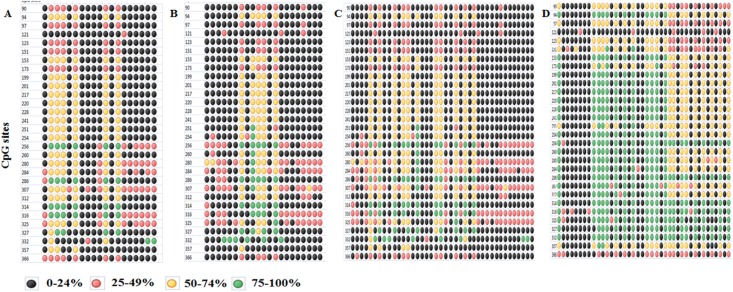
Dot plot of ABCB1 promoter DNA methylation at 30 CpG sites.Complicated malaria (Panel A), Uncomplicated malaria (Panel B), All malaria cases (Panel C) and Controls (Panel D).